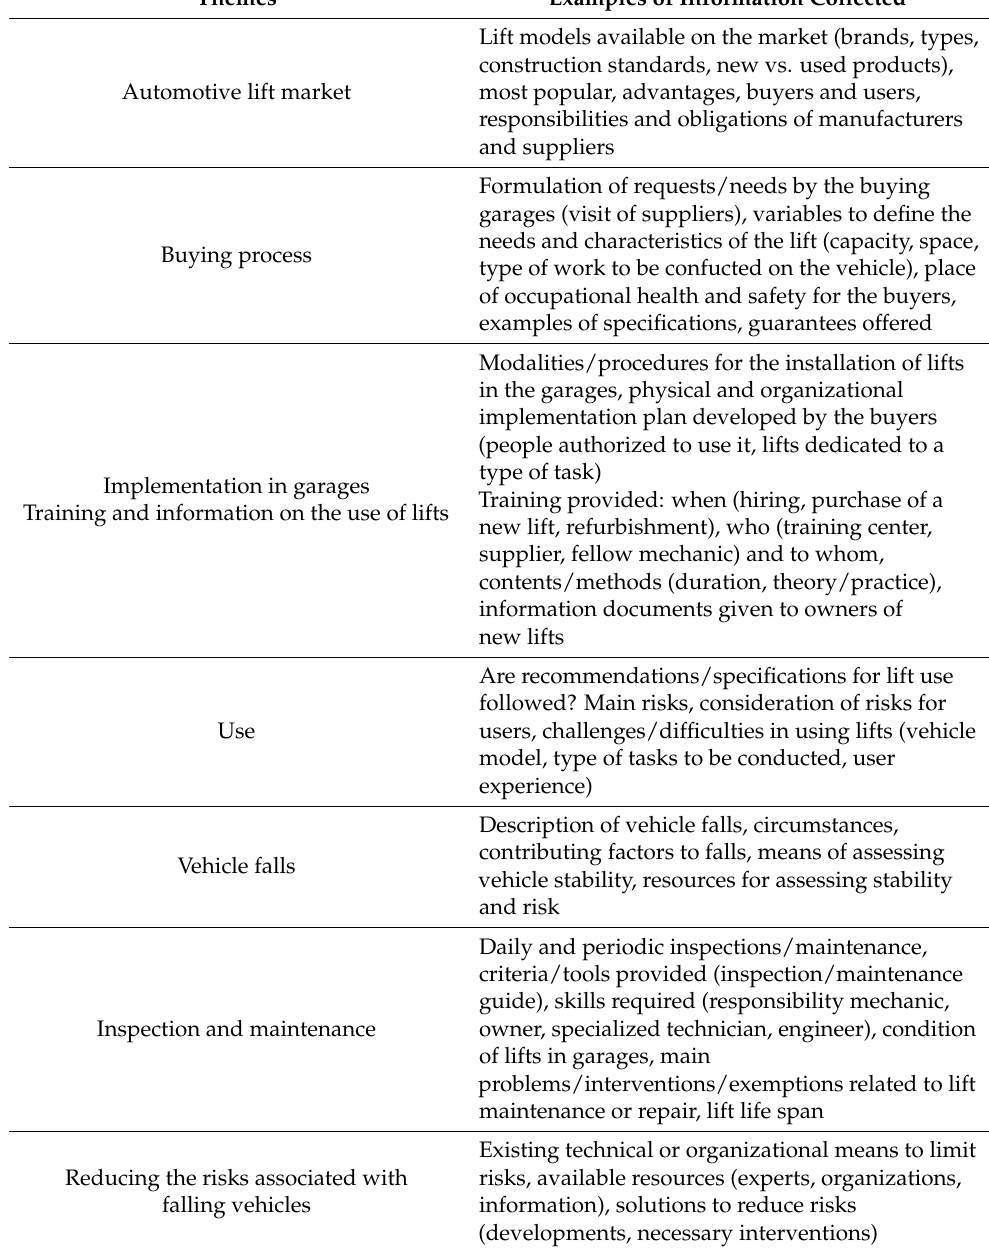
Table 1. Themes covered during interviews with key players in the automotive